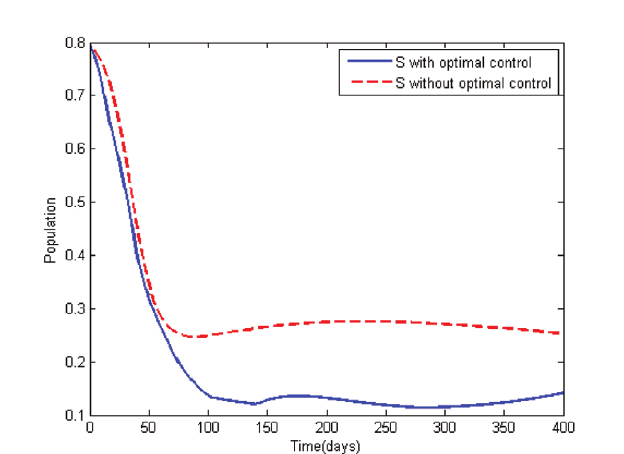
Figure 4 . Comparison of SIR and Monte Carlo Models With and Without Optimal